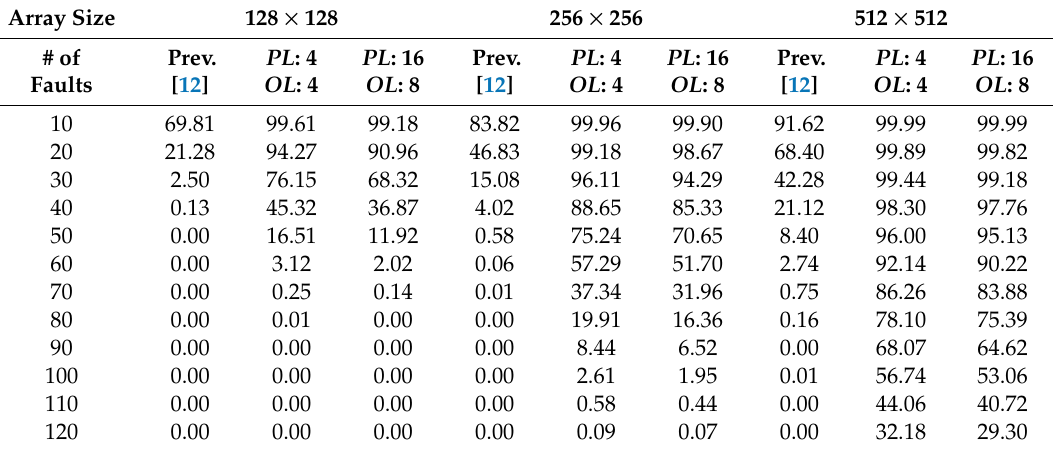
Table 1. Repair rates comparison with the previous architecture (unit: %).